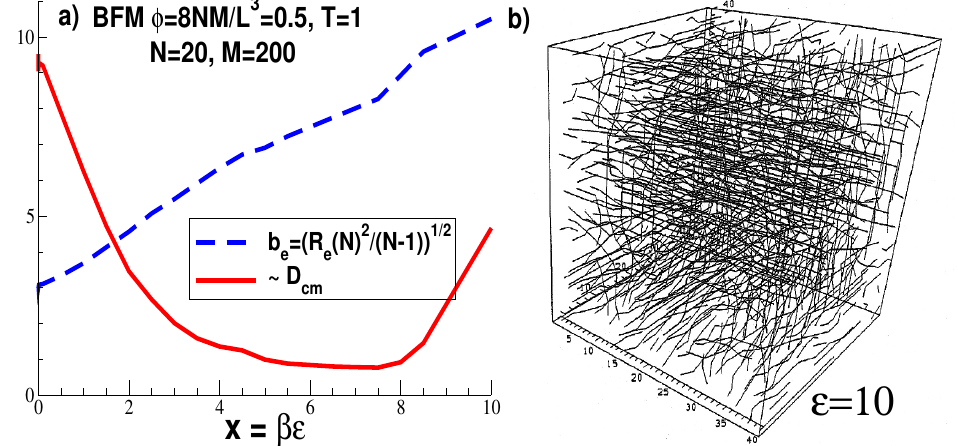
Figure 1. Stiffness effects and lattice artifacts for bond-fluctuation model (BFM) data obtained for M = 200 chains of length N = 20 at a volume fraction φ = 8 NM / V = 0.5 of occupied lattice sites at a temperature T = 1/ β = 1 [41]. Panel ( a ) shows the effective bond length b e = R e ( N ) / ( N − 1 ) 1/2 , obtained from the root-mean-squared chain end-to-end distance R e ( N ) and the (rescaled) center-of-mass self-diffusion coefficient D cm as a function of the dimensionless parameter x = β(cid:101) . A snapshot of a configuration at (cid:101) = 10 is given in Panel ( b ). The chains are seen to align along the three principal lattice